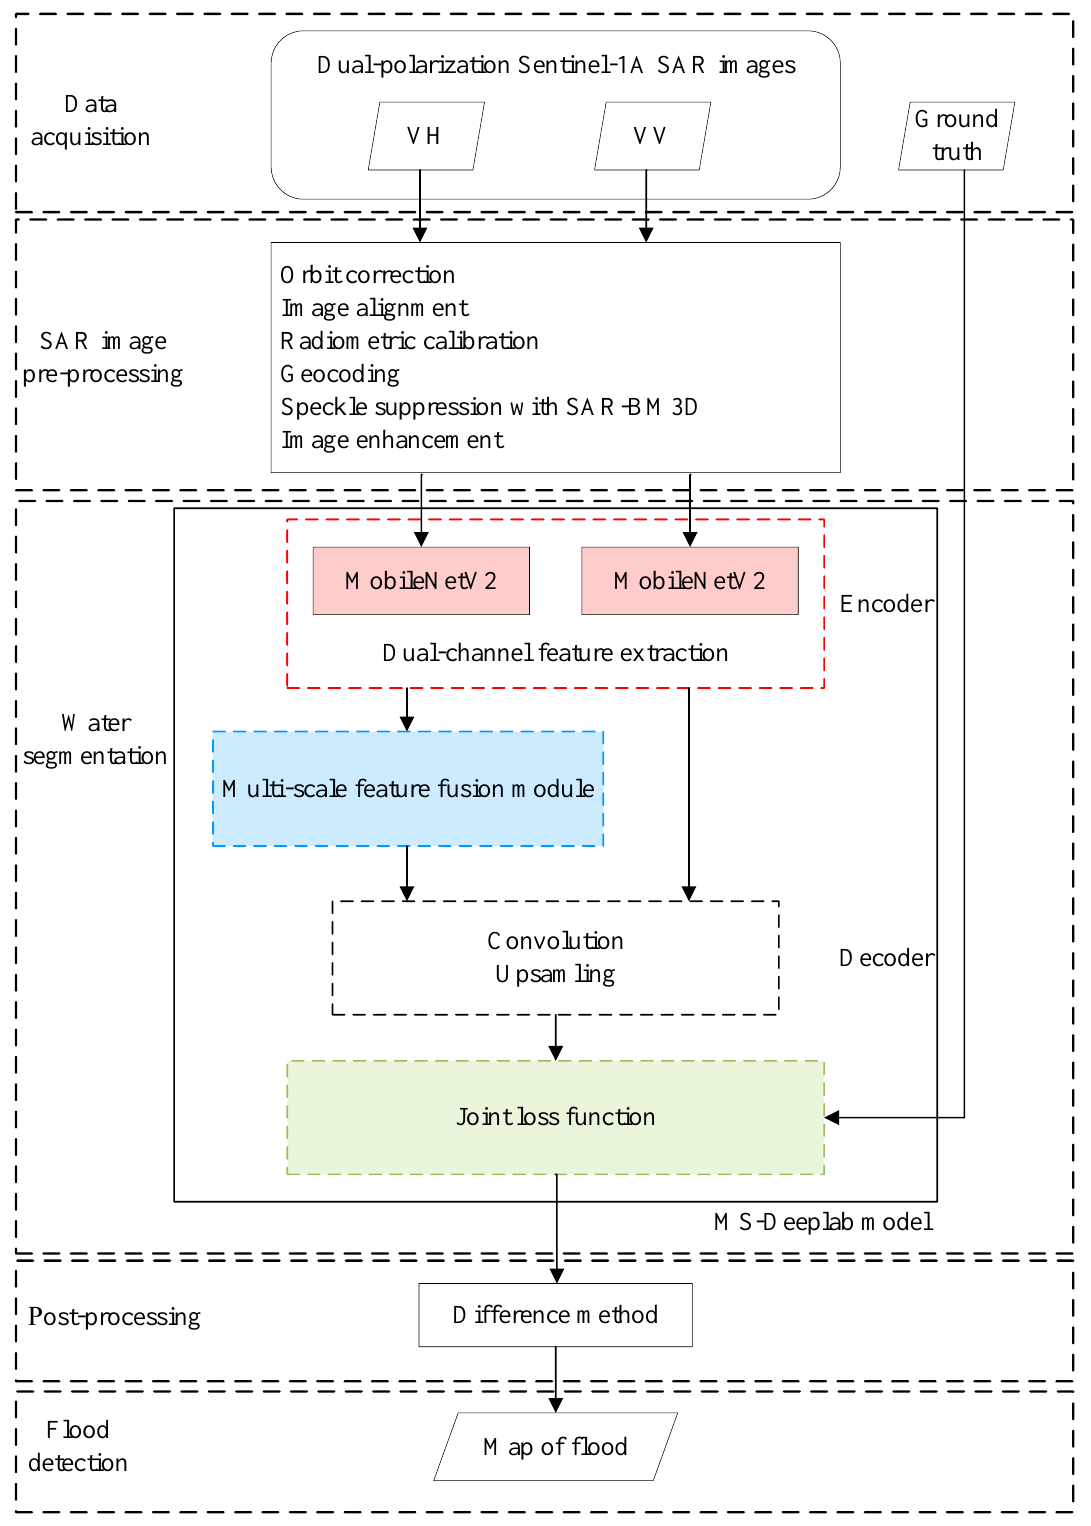
Figure 6. The flowchart of the proposed flood detection